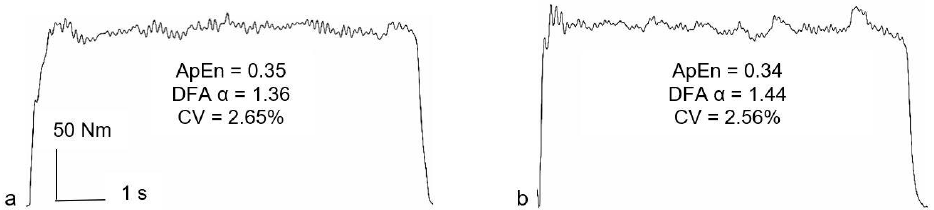
Figure 2. Raw output from a trial for a participant with similar complexity and variability values on the right ( a ) and left ( b ) sides. Nm = Newton-meters; s = seconds; ApEn = approximate entropy; DFA α = detrended fluctuation analysis α ; CV = coefficient of variation. ApEn right/left limb-symmetry- index = 102.9%; ApEn right/left absolute-asymmetry = 2.9%. DFA α right/left limb-symmetry-index = 94.4%; DFA α right/left absolute-asymmetry = 5.6%. CV right/left limb-symmetry-index = 103.5%; CV right/left absolute-asymmetry = 3.5%.